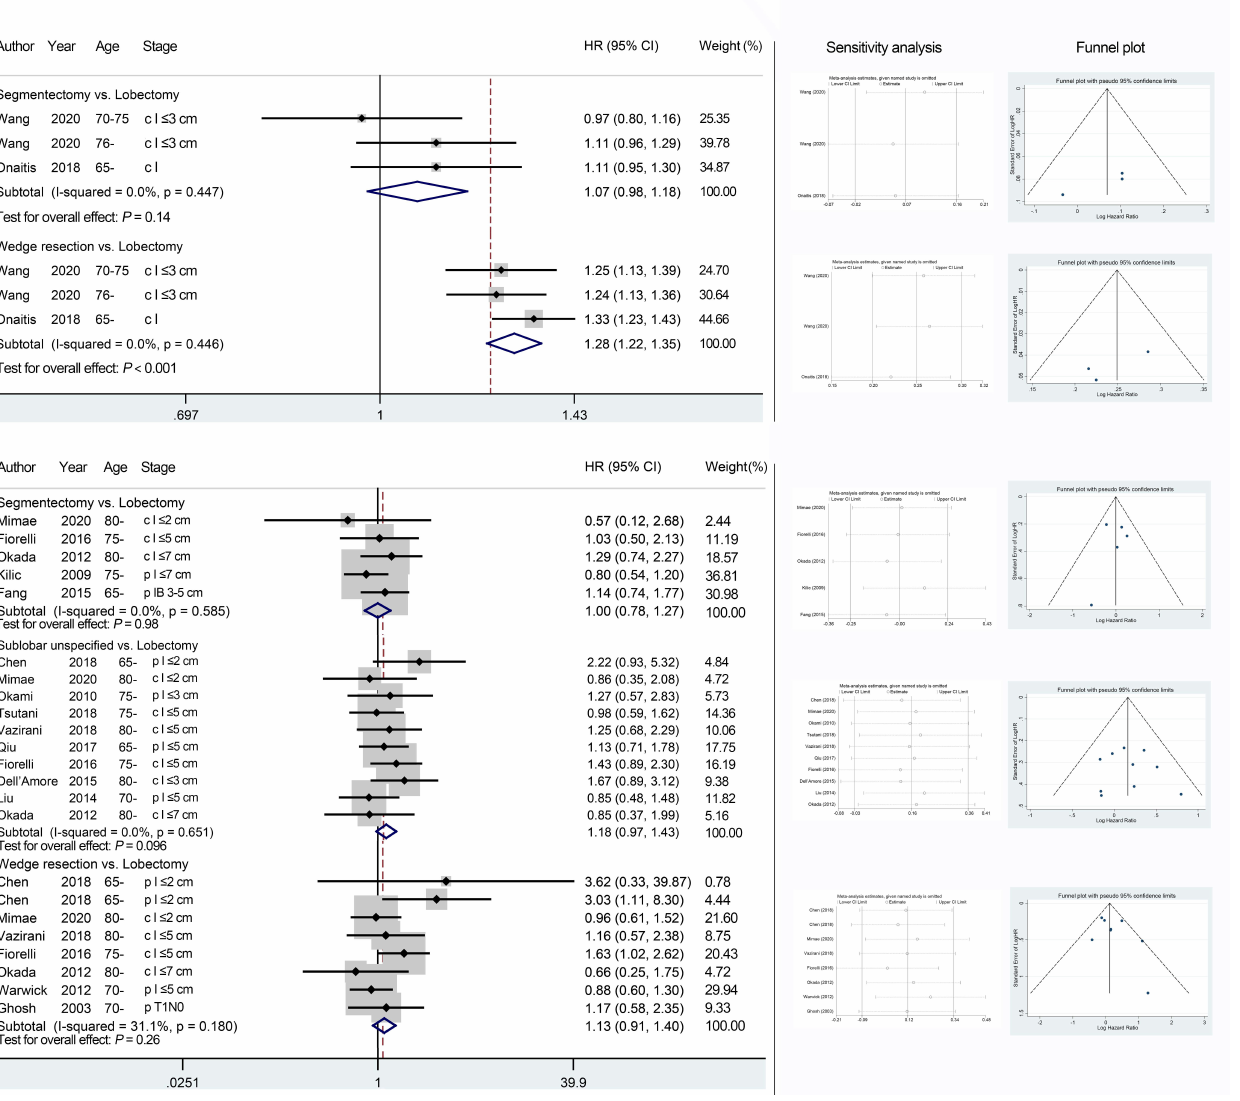
Figure 2. Meta-analyses comparing the overall survival outcomes of sublobar resections with those of lobectomy using database studies ( a ) or cohort studies ( b ). The right panel presents the outcomes of sensitivity analyses and the funnel plots corresponding to the forest plots shown in the left panel. HR, hazard ratio; CI, confidence